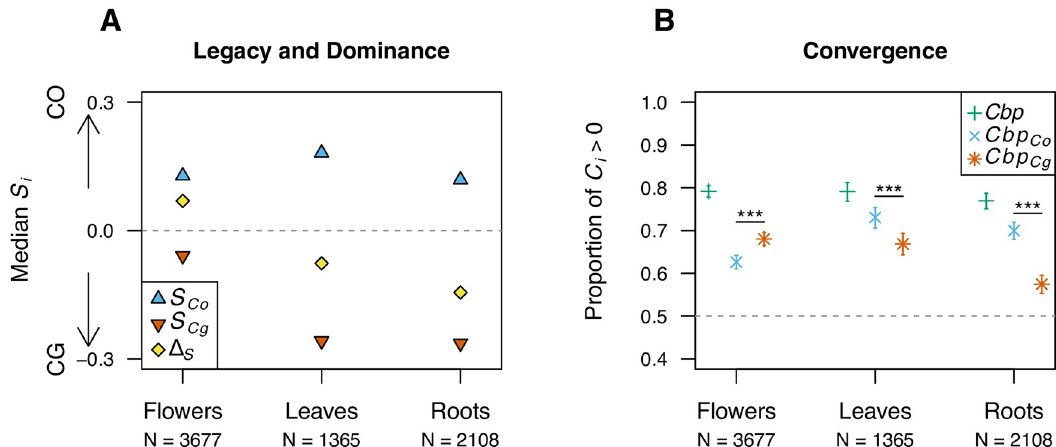
Fig 7. Similarity and convergence indices for differentially expressed genes between subgenomes of C. bursa-pastoris . A . For each tissue and each subgenome, the median of similarity indices for each subgenome ( S difference between the two indices ( Δ ) that indicates the dominance of one parental genetic background. Grey dotted lines ( S = 0) S indicate level of no bias. B . The proportion of transcripts showing convergence ( C i > 0) is reported for the whole genome (green plus signs) or each subgenome ( Cbp , Cbp ). The significance of difference between the subgenome convergence indices is also Co Cg depicted (binomial test, ��� , p < 0.001). The number of differentially expressed genes considered for each tissue are indicated with N.